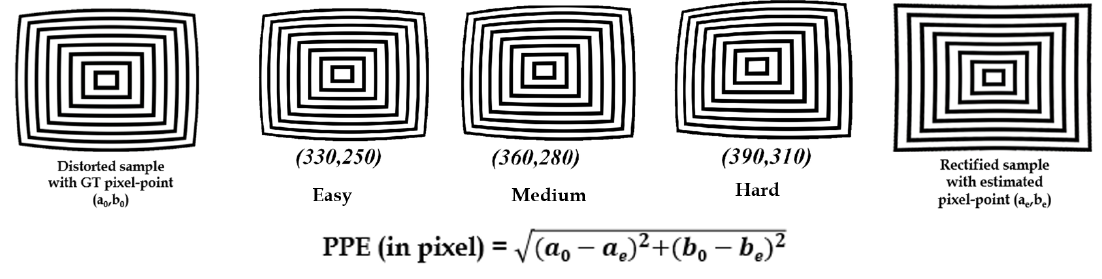
Figure 7. Pixel-point error calculation on distortion center synthetic dataset